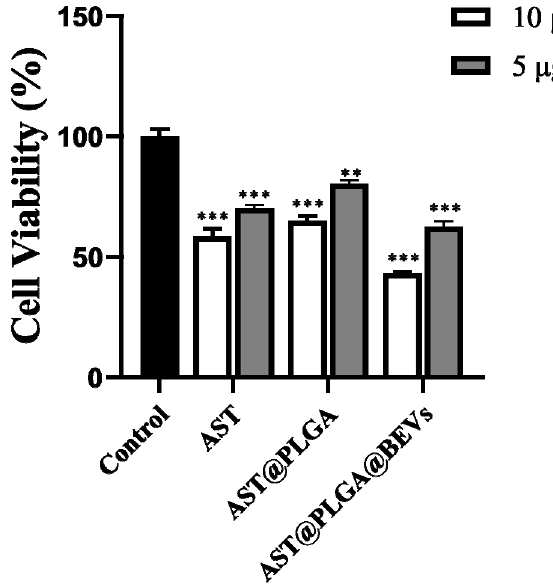
Figure 6. Effect of cell proliferation on HT ‐ 29 cells. * P <0.05; ** P <0.01; *** P <0.001, vs Control group.